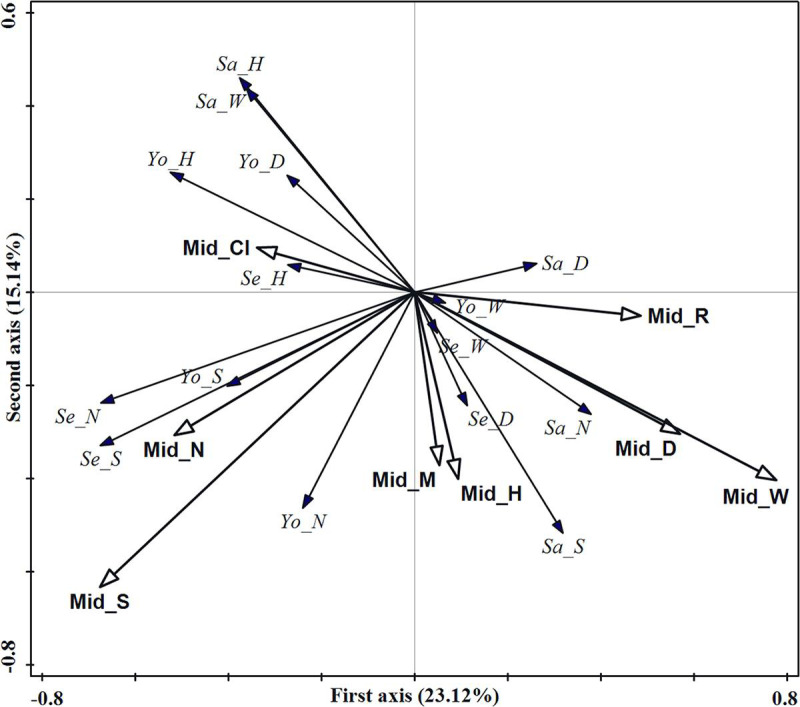
RDA ordination diagram of middle forest stratum structure indices
and regeneration in the evergreen broad-leaved forest.Hollow arrows represent stand structure indices and solid arrows
represent regeneration indicators. Mid_M, Mid_CI, Mid_R, Mid_S,
Mid_DBH, Mid_H, Mid_W and Mid_N denote the mingling, competition
index, aggregation index, tree species richness index, diameter at
breast height, tree height, crown width and density, respectively.
Se_N, Se_D, Se_H, Se_W and Se_S denote seedling density, basal
diameter, tree height, crown width and tree species richness index,
respectively; Sa_N, Sa_D, Sa_H, Sa_W and Sa_S denote sapling
density, basal diameter, tree height, crown width and tree species
richness index, respectively; Yo_N, Yo_D, Yo_H, Yo_W and Yo_S denote
young tree density, diameter at breast height, tree height, crown
width and tree species richness index, respectively.